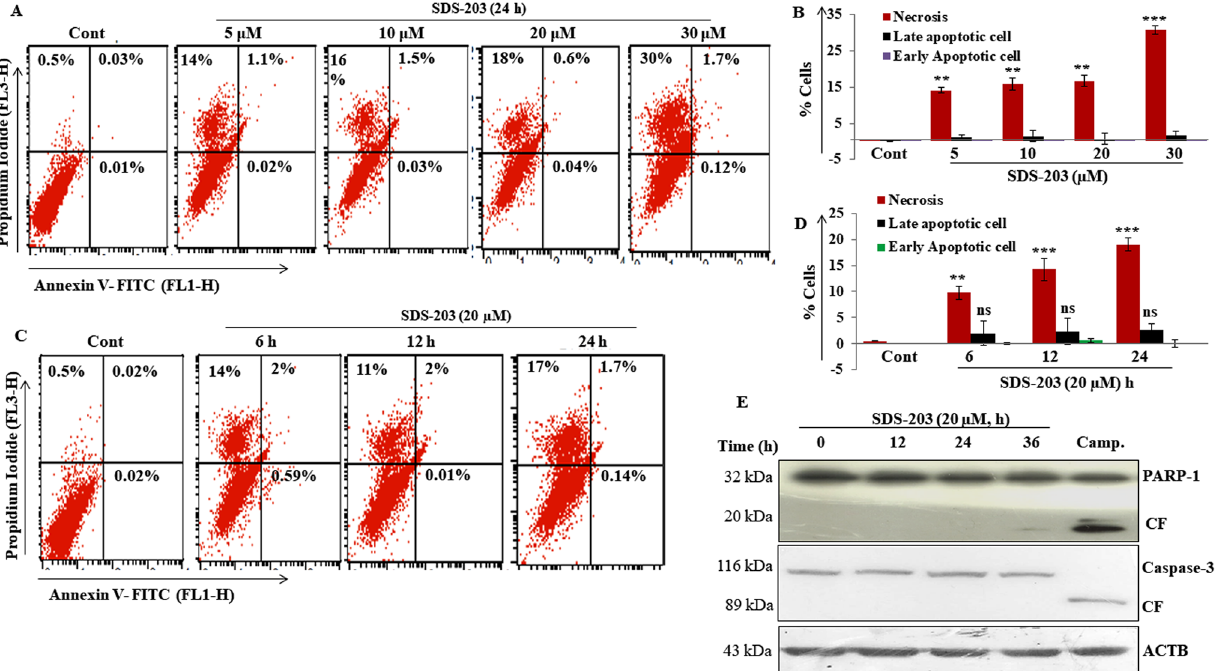
Figure 1. SDS-203 decreases cell viability by the non-apoptotic way in pancreatic cancer cell line MIA PaCa-2. ( A – D ) MIA PaCa-2 cells were incubated with different concentrations of SDS-203 (5, 10, 20, 30 μM) for 24 h or single concentration (20 μM) for various time points (0, 6, 12, 24 h) then cells were stained with Annexine- VFITC and PI (1 μg/mL) followed by quantification of apoptotic cells by flowcytometry ( E ) MIA PaCa-2 cells were treated with SDS-203 (20 μM) in a time-dependent manner (0, 12, 24, 36 h) and protein expression of cleaved PARP1 and cleaved Caspase3 were determined by western blotting, camptothecin (1 μM) was taken as a positive control. Each experiment was repeated three times. p -value represents: ** p < 0.01; *** p < 0.001vs.